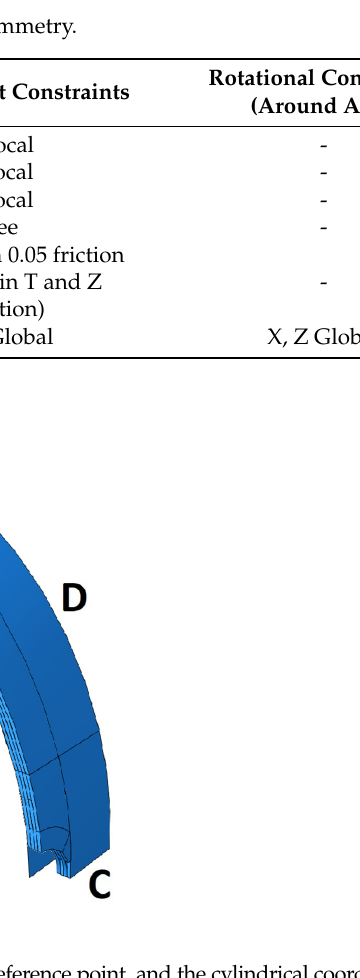
Figure 15. Overview of constraints, surface names, reference point, and the cylindrical coordinate system.